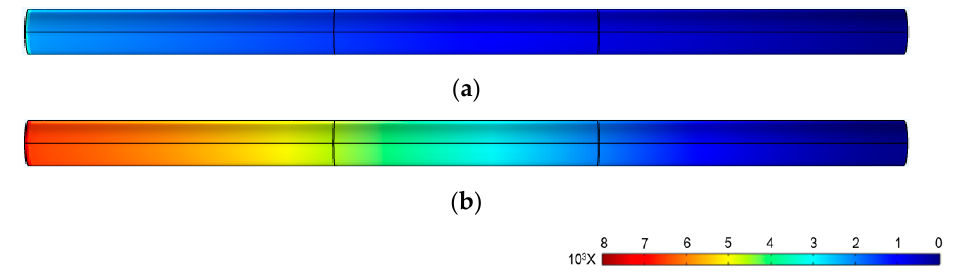
Figure 13. Pressure distribution in the microchannel. ( a ) The pressure distribution without photo- voltage and ( b ) the pressure distribution with saturation photovoltage produced using PLZT ceramic under 200 mW/cm 2 .